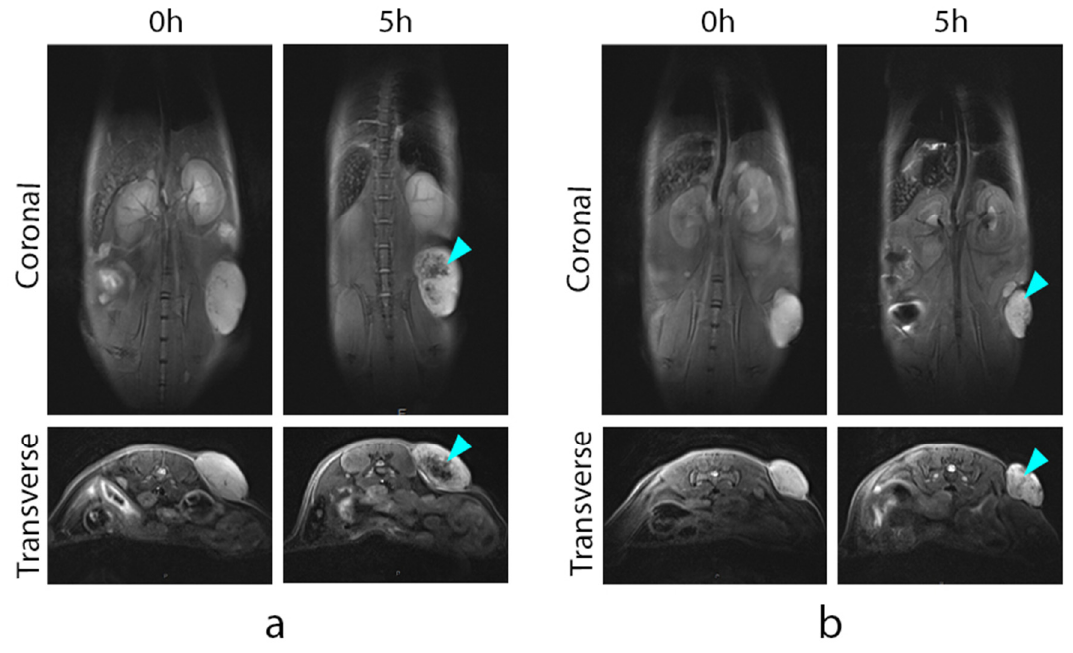
Figure 7. Representative T2-weighted images of mice with subcutaneously implanted 4T1 tumor before (0 h) and 5 h after the intravenous injection of the hMNP ( a ) and Absolute Mag™ nanoparticles (CD-MNP) ( b ) (3.5 mg/kg Fe). Negatively contrasted tissues indicate the hMNP and CD-MNP accumulation (blue arrowheads). Coronal and transverse projections are demonstrated.